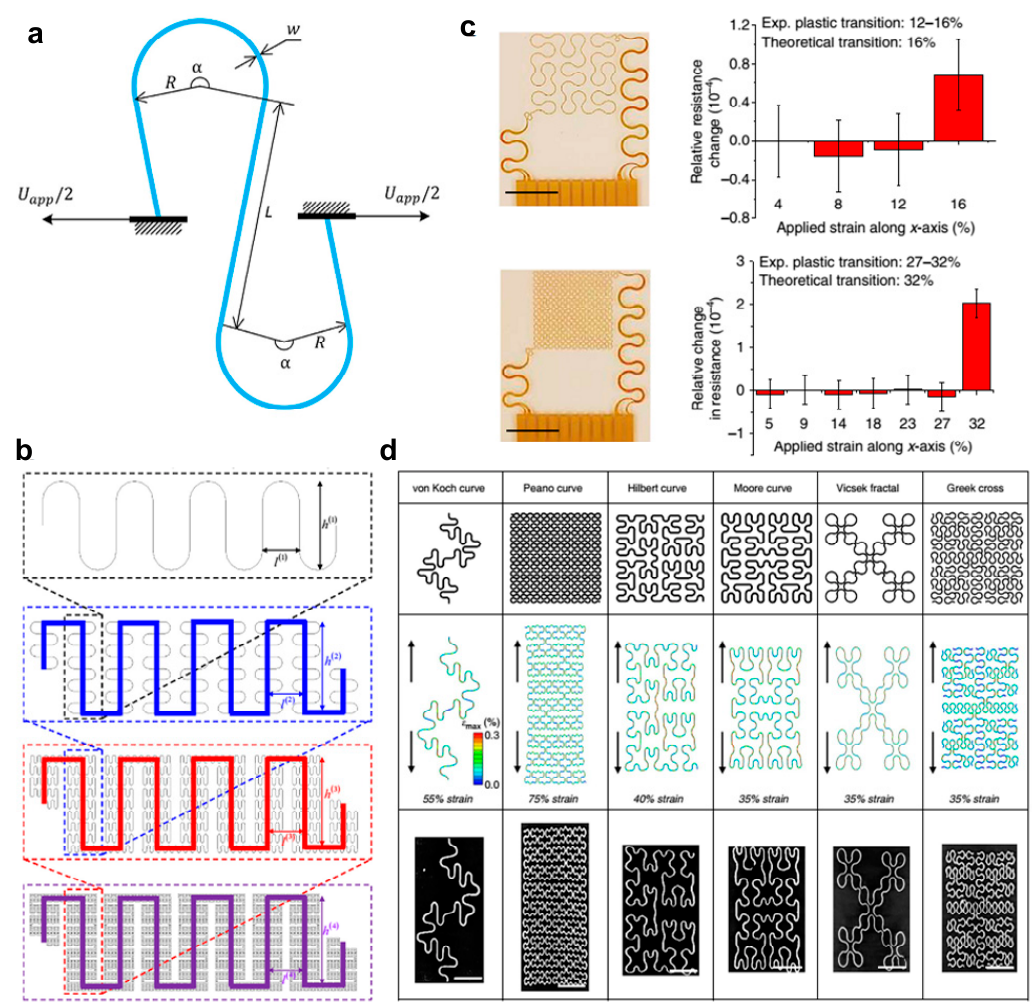
Figure 3. Mechanisms of serpentine and fractal structures: ( a ) a serpentine interconnect subjected to an axial stretching ( U app ) at the two ends (Reprinted with permission from Ref. [47] Copyright 2016 Elsevier); ( b ) schematic illustration on the geometric construction of self-similar serpentine interconnects (Reprinted with permission from Ref. [48] Copyright 2013 Elsevier); and ( c , d ) representatives of fractal structures (Reprinted with permission from Ref. [45] Copyright 2014 Nature Publishing Group).